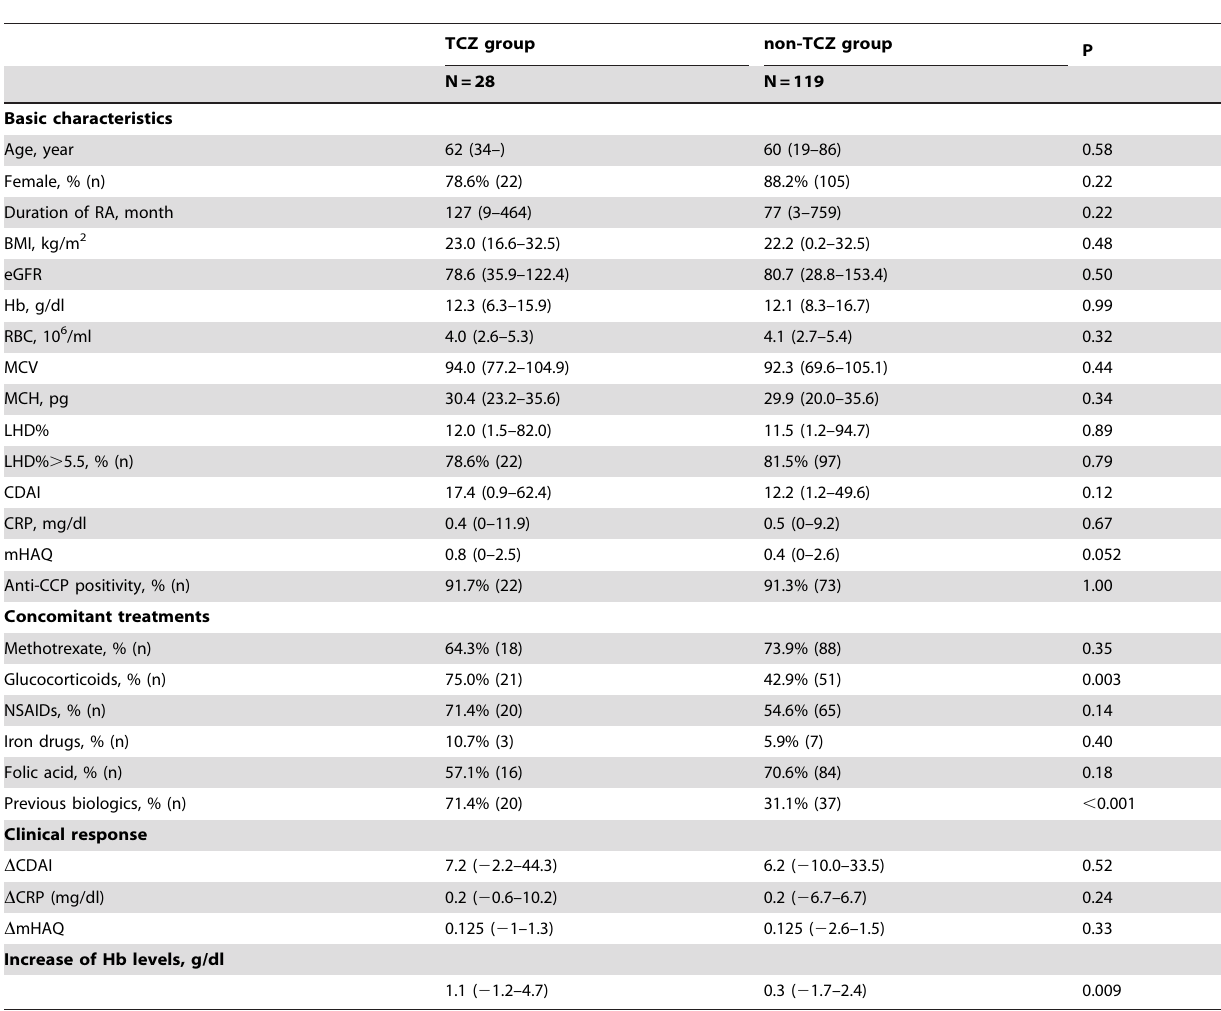
Table 1. Characteristics of the study population and increase of Hb levels after biologic